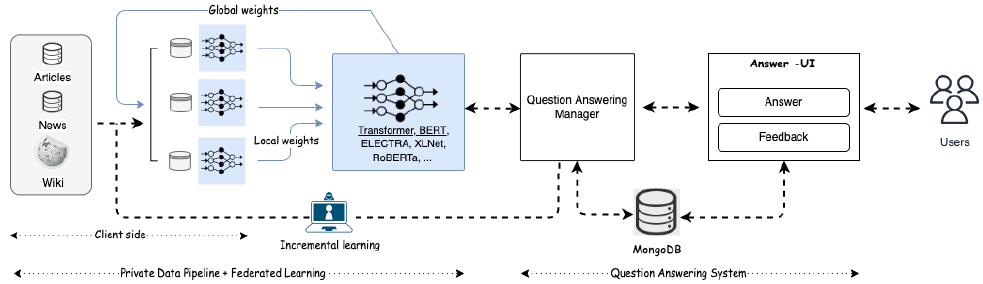
Figure 2. Overview of the FedQAS architecture. The FedQAS approach is organized in three main logical layers, the first one is for collaborative privacy-preserving training, the second one is a federated question answering manager, and the third is for incremental learning and private data generation.